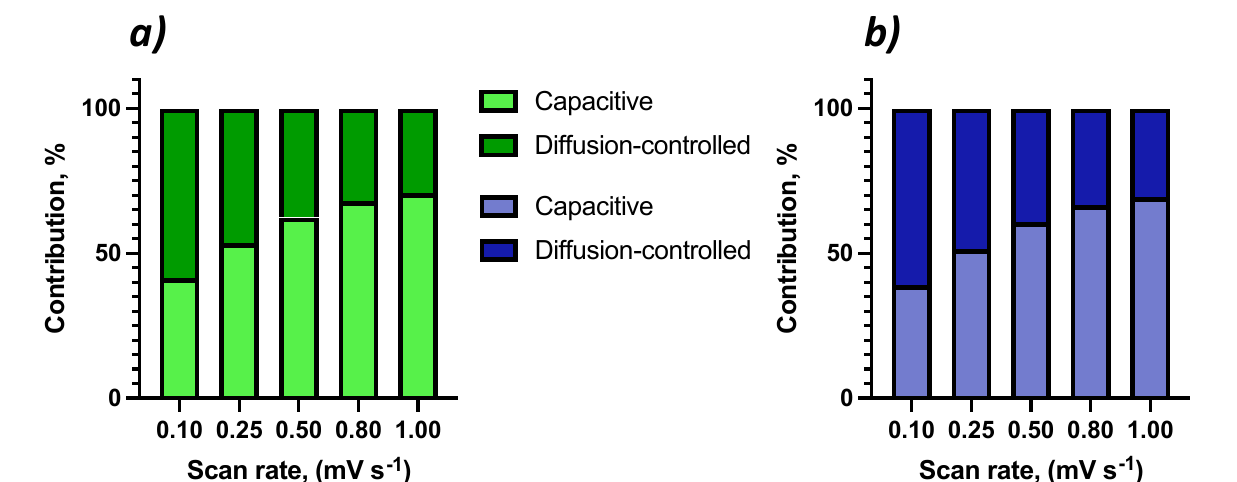
where D —diffusion coefficient (cm 2 s − 1 ); slope —the slope of the graph; n —number of elec- trons that participate in a reaction; F —Faraday constant (C mol − 1 ); A —surface area of the electrode (cm 2 ); C —electrolyte concentration (mol cm − 3 ); R —universal gas constant (J K − 1 mol − 1 ); T —temperature (K).